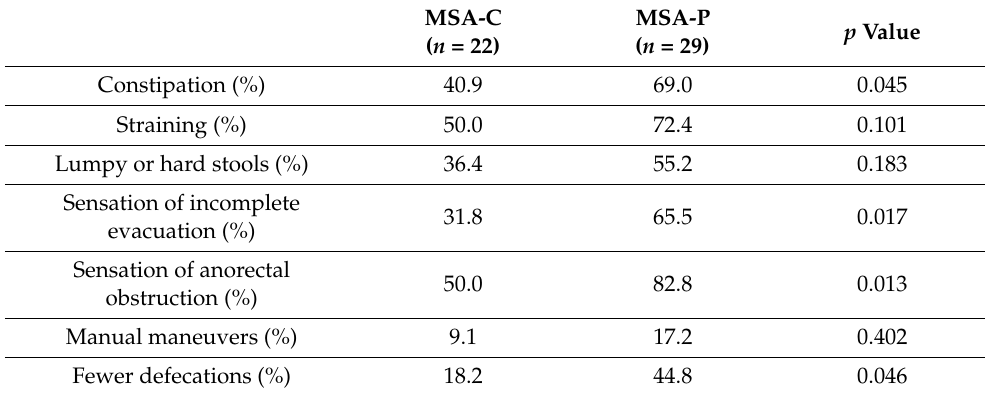
Table 5. Comparison of constipation symptoms among groups of MSA-C and